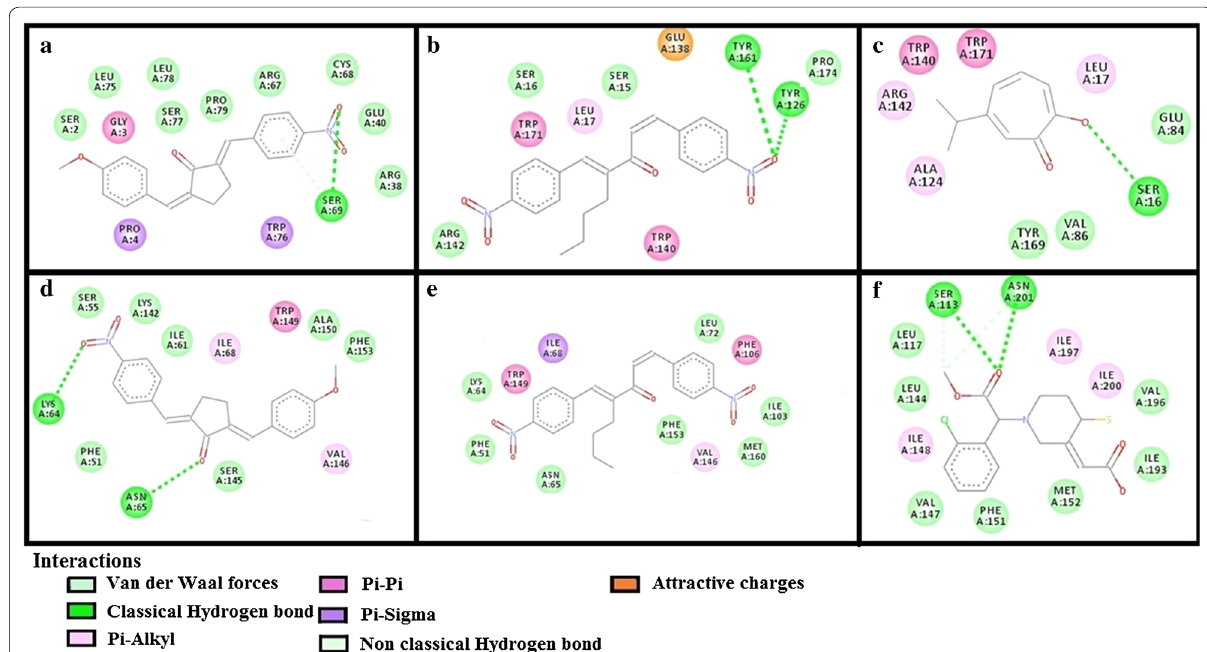
Fig. 8 a – c Represents interactions of ligands: (2 E ,5 E )‑2‑(4‑methoxybenzylidene)‑5‑(4‑nitrobenzylidene) cyclopentanone (AK‑1a), (1 E ,4 E )‑4‑(4‑nitro benzylidene)‑1‑(4‑nitrophenyl) oct‑1‑en‑3‑one (AK‑2a) and hinokitiol with target: glycoprotein‑VI (GP‑VI) respectively. d – f represents interactions of AK‑1a, AK‑2a and clopidogrel with target: purinergic receptor (P 2 Y 12 ) respectively, drawn through Biovia Discovery Studio Visualizer client 2016